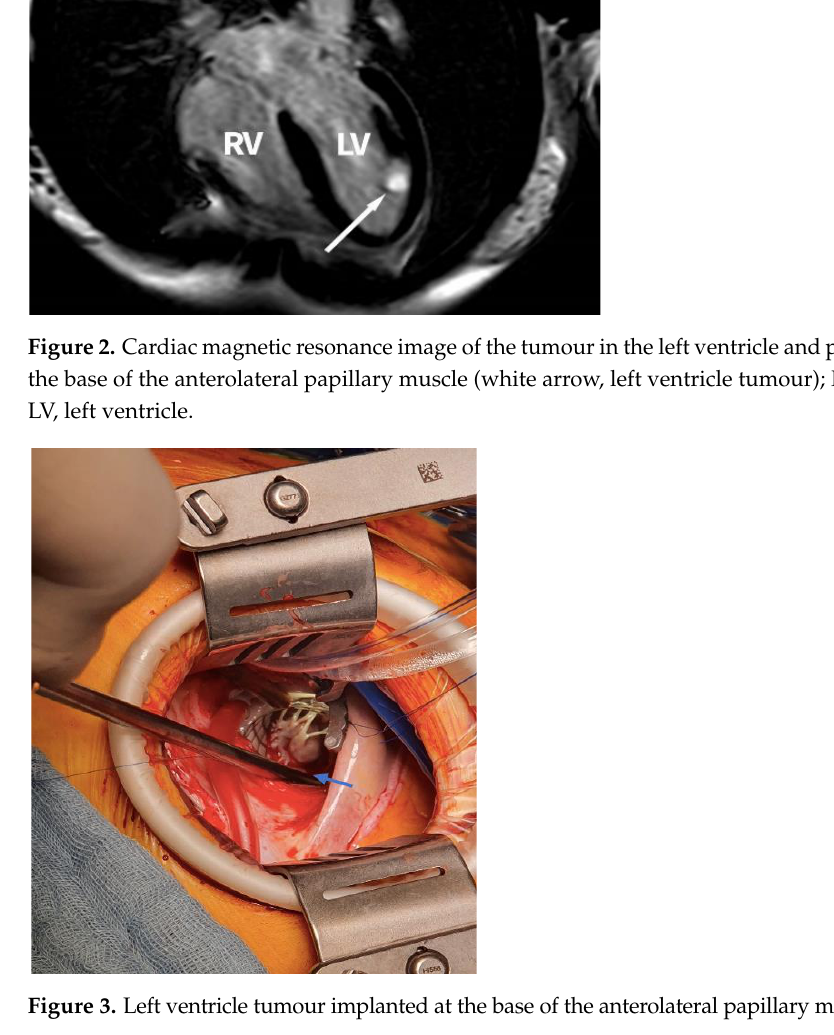
Figure 2. Cardiac magnetic resonance image of the tumour in the left ventricle and papillary muscle at the base of the anterolateral papillary muscle (white arrow, left ventricle tumour); RV, right ventricle; LV, left ventricle .